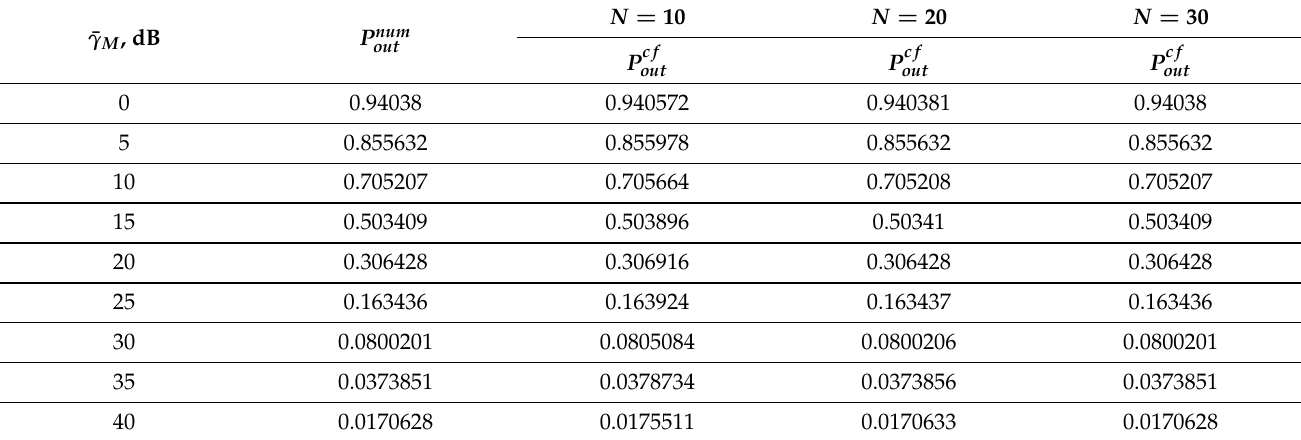
Table 1. A comparison between the numerical and closed-form solutions for C th = 0.3, ¯ γ W = 10